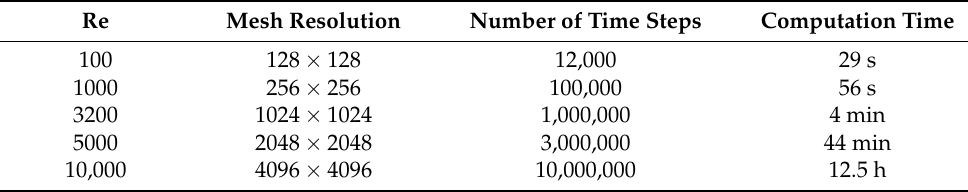
Figure 2. Lid-driven cavity results for Re = 5000 and D2Q9 lattice with 2048 × 2048 resolution. The picture on the left was generated from simulation results with ParaView [29] and shows the magnitude of velocity and streamlines (denoted with white lines) after 3 × 10 6 time steps. The plot on the right contains a comparison of velocity profiles (lines) with the reference solution (symbols) adapted from [28]. The complete simulation took about 44 min on a GPU. Table 1. Validated cavity simulations for different Reynolds numbers Re. Time of computations is given for GTX Titan Xp GPU and includes the compilation of kernels (about 20 s) and a few dozens of saves of the simulation state to the